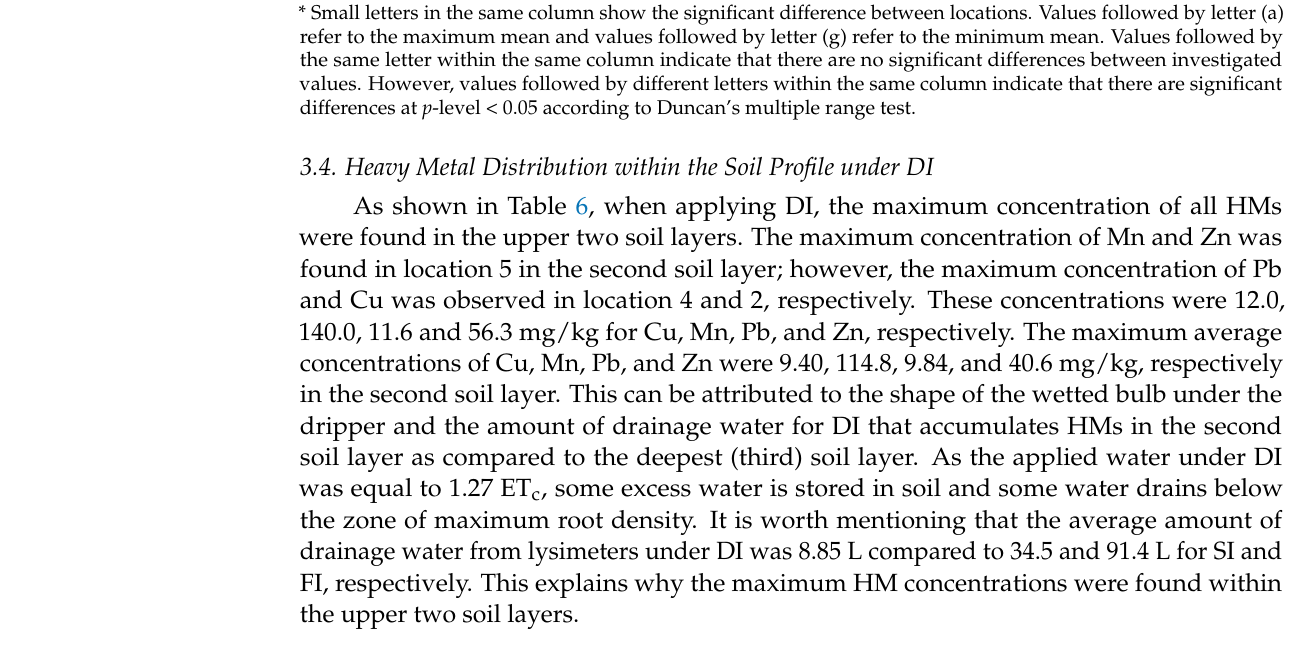
Table 6. HM concentrations * (mean ± SE; mg/kg soil) in different locations within the soil profile under DI at the end of growing